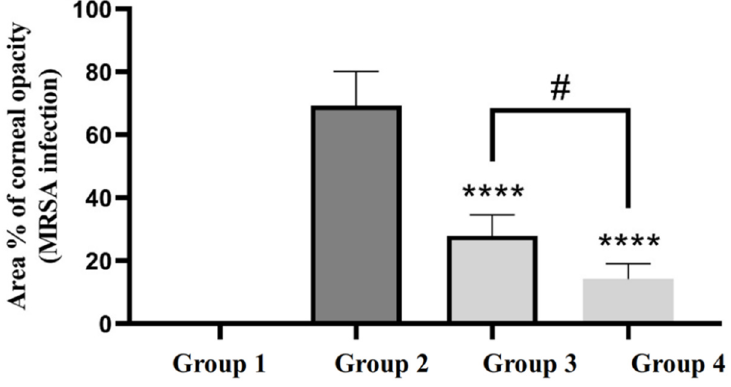
Figure 5. The area % of corneal opacity in different groups of rats. ****, group 4 and 3 compared to group 2 ( p < 0.0001); #, group 4 compared to group 3 ( p < 0.05).